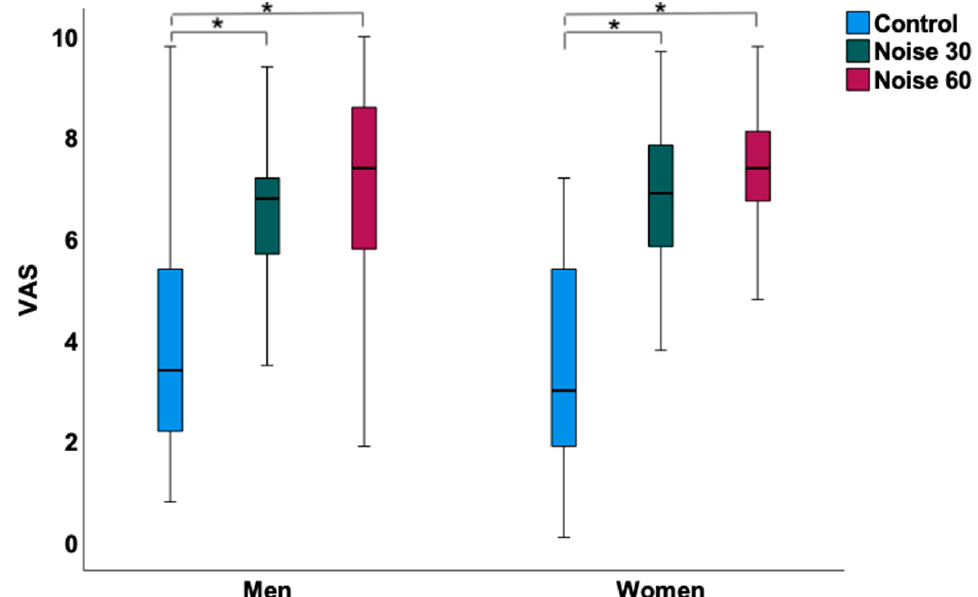
Figure 1. Effects of nocturnal train noise on sleep quality in men ( n = 33) and women ( n = 35) measured via visual analogue scale (VAS ranging from 0–10 cm with higher values indicating pronounced impaired sleep quality). Exposure to both train noise patterns impaired sleep quality, although no difference was observed between Noise 30 and Noise 60 study nights. * denotes p < 0.001. Box plots indicate minimum, maximum, 25th percentile, median, and 75th percentile.